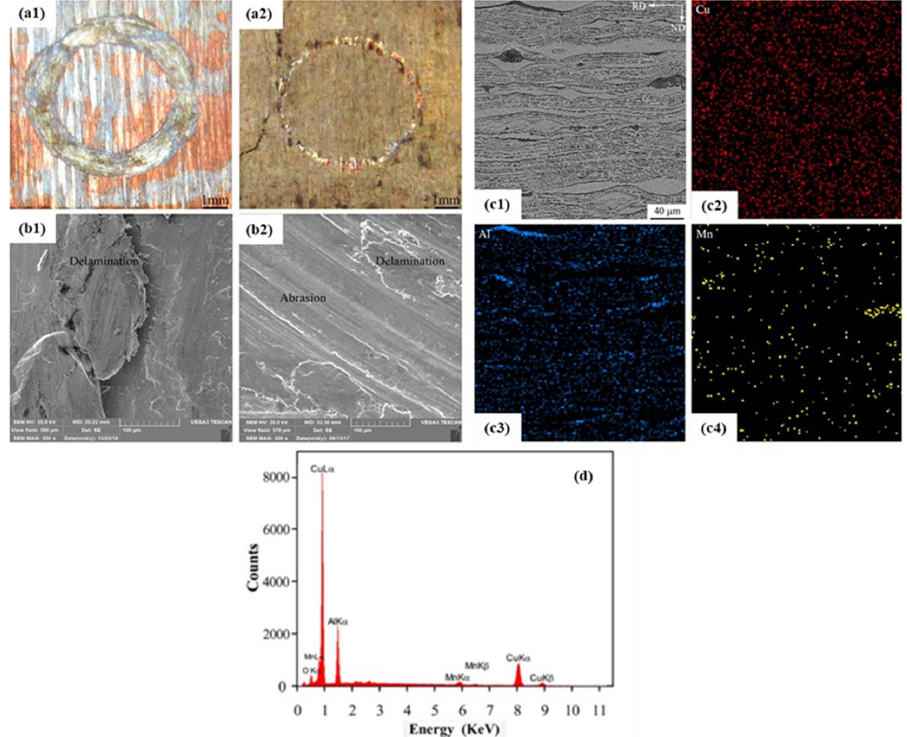
Figure 15. The ARB processed Cu–26Zn–5Al shape memory alloy, the wear track of ( a 1